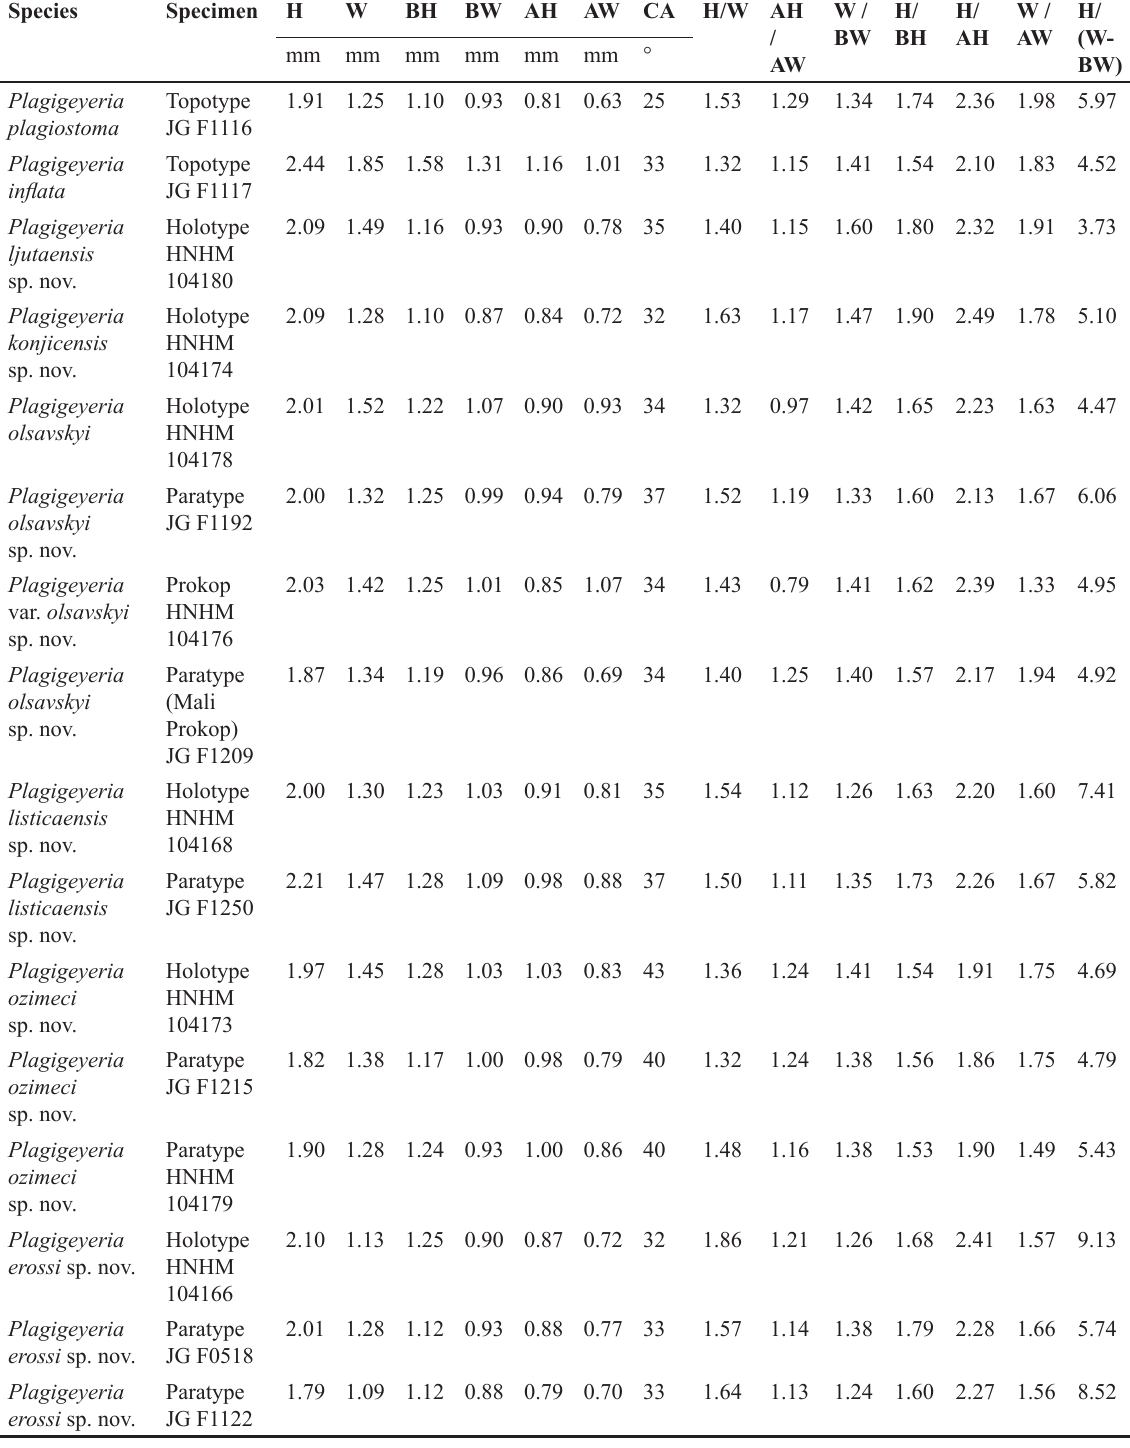
Table 2. Shell morphometry comparison of Plagigeyeria plagiostoma (A. J. Wagner, 1914) , P.